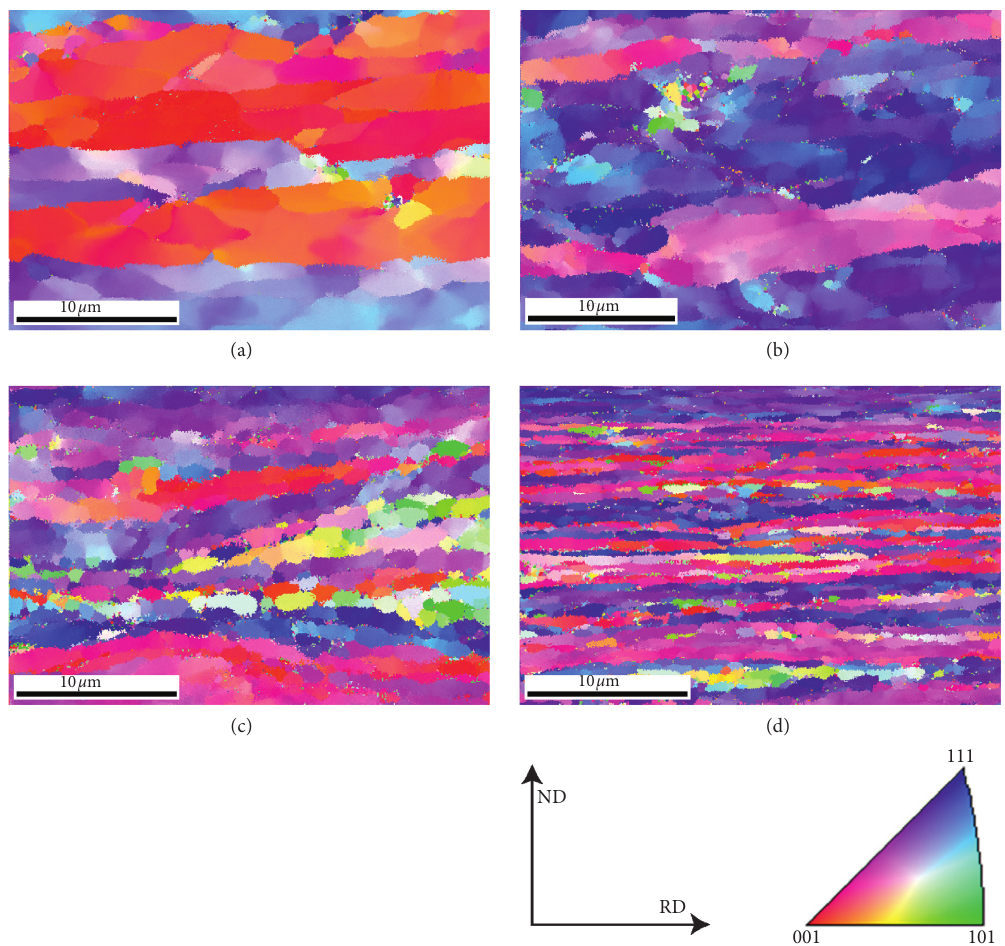
Figure 4: The orientation maps of aluminum in the Al-Nb/Ti/Ni composites: (a) the first pass, (b) the second pass, (c) the third pass, and (d) the fourth